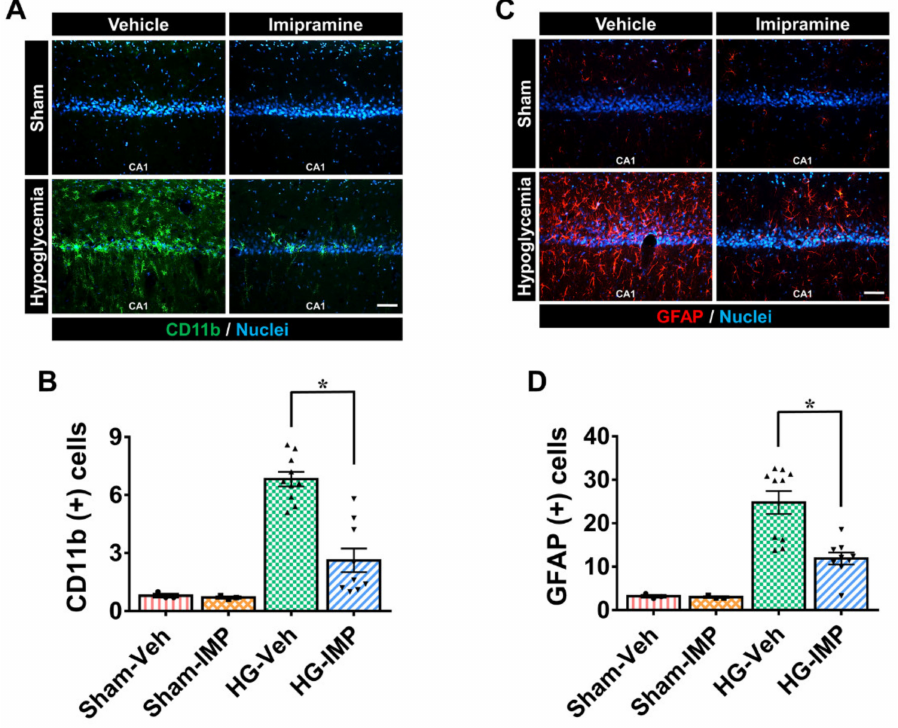
Figure 4. Administration of imipramine reduced microglial and astrocyte activation after hypo- glycemia. To determine microglia and astrocyte activation, we conducted CD11b and GFAP staining, respectively. Hypoglycemia-induced microglia and astrocyte activation trigger an immune